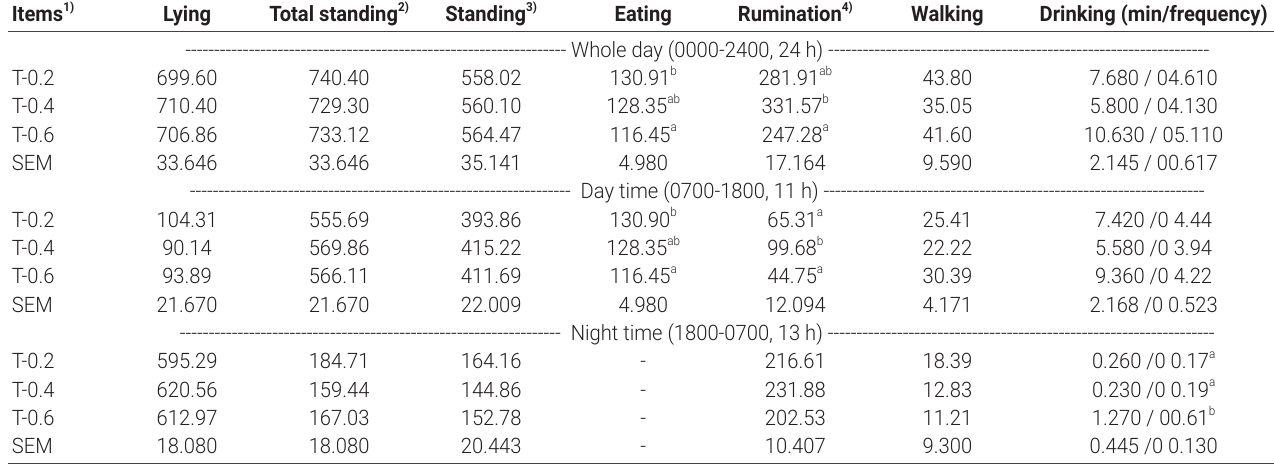
Table 5. Observation of animal behaviors (min) in Hanwoo heifers fed different energy and crude protein intake levels Items 1) Lying Total standing 2)